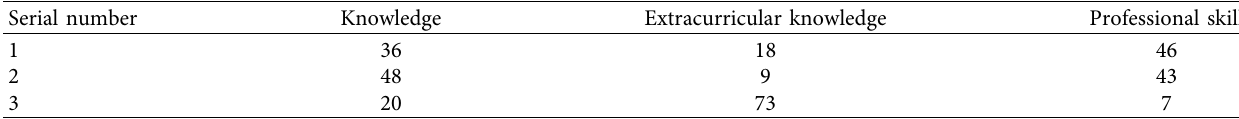
Table 3: Knowledge level quality professional.